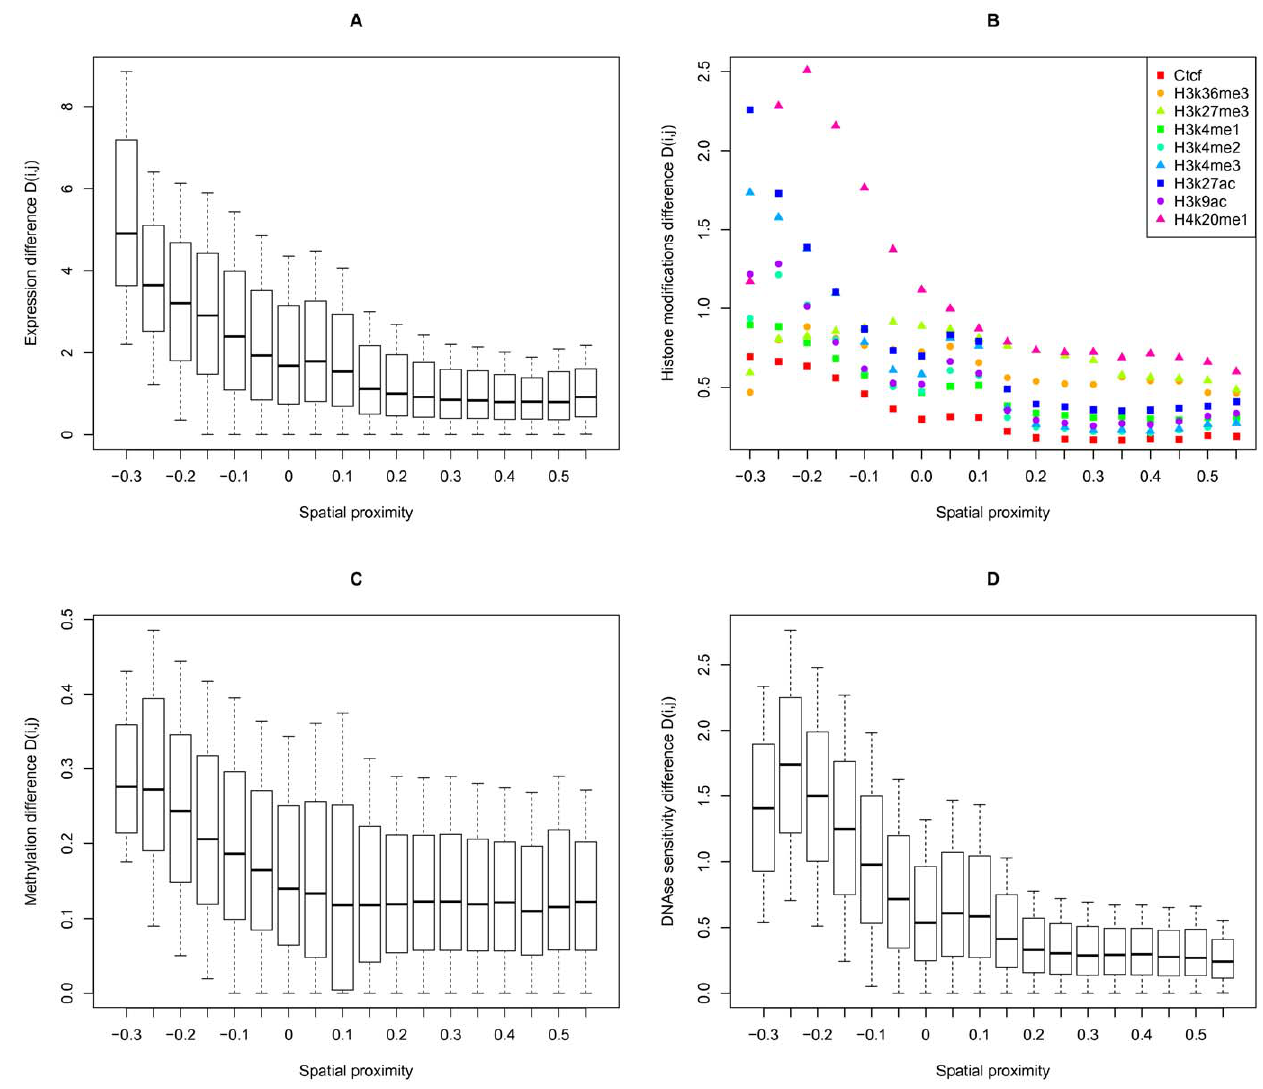
Figure 3. Correlations of the spatial proximity values with expression (A), histone modifications (B), DNA methylation (C), and DNAse sensitivity (D) differences. The whisker boxes (A,C,D) are as in Fig. 1. Symbols in B show the medians for different histone modifications; the whisker boxes for all modifications are given in Fig. S1.